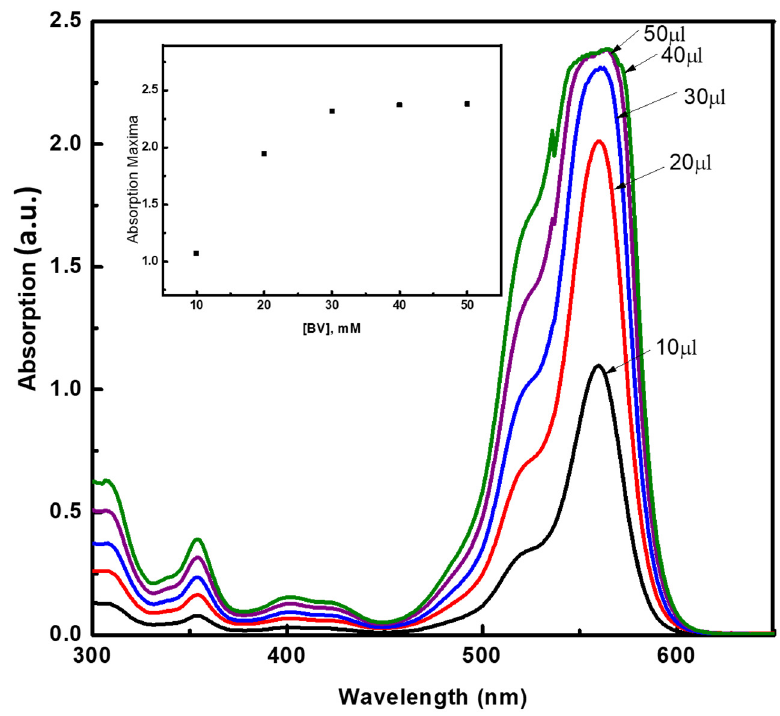
Figure 3. Absorption spectra as a function of the concentration of BV in the monomer mixture,